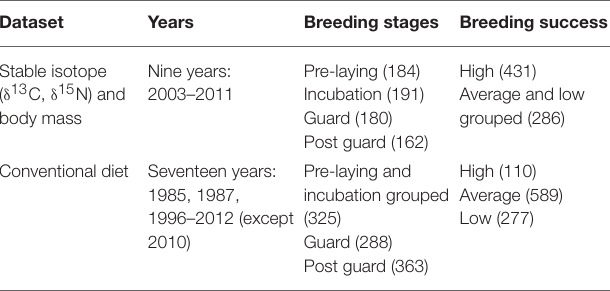
TABLE 1 | Structure of datasets used in this study.